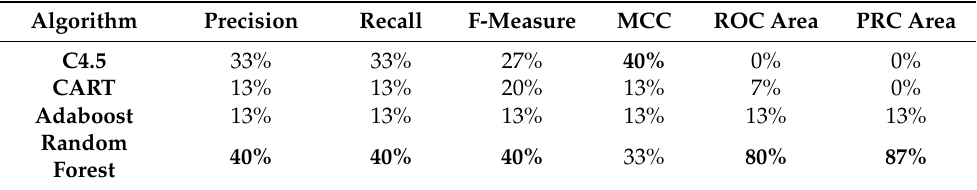
Table 7. Percentage of incidents in which each algorithm obtained a better score applicable to the attributes of the study